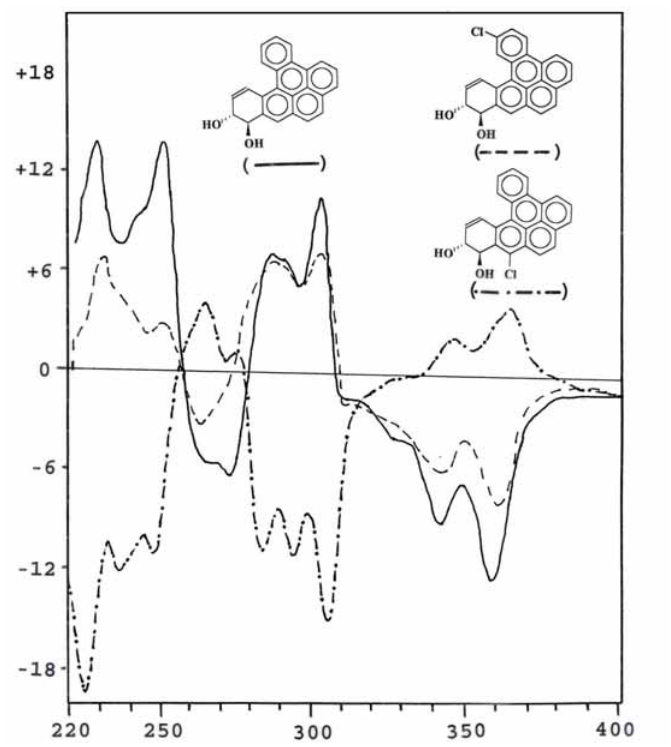
Figure 2. CD spectra of DB[ a,l ]P trans -11,12-dihydrodiol, 2-Cl-DB[ a,l ]P trans -11,12-dihydrodiol, and 10-Cl-DB[ a,l ]P trans